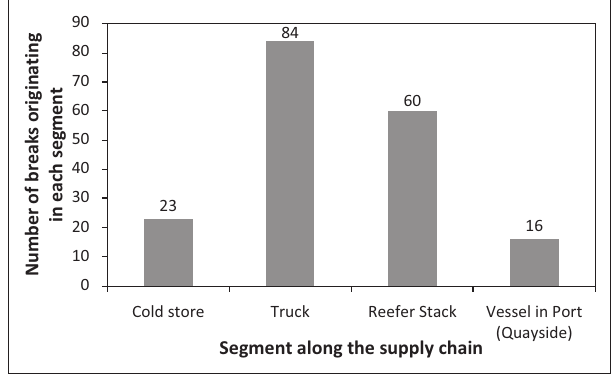
FIGURE 4: Number of breaks originating in respective cold chain segments of the 2011/2012 season.